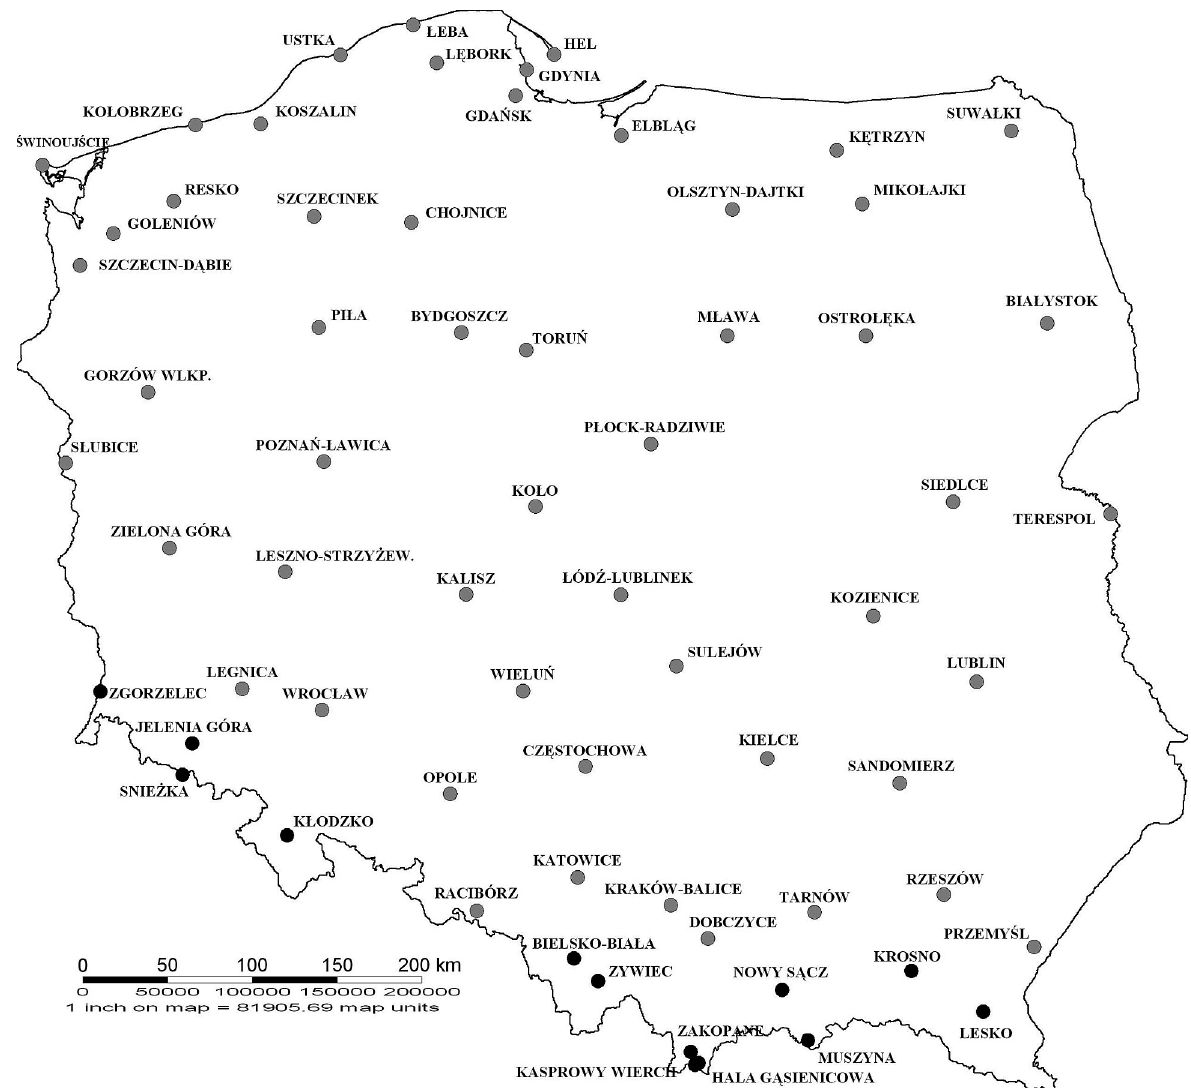
Fig. 1. Distribution of meteorological stations used in the study. Black dots represent stations in the mountain area and the